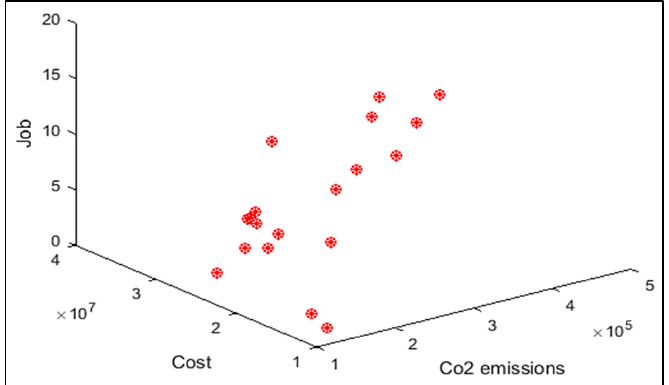
Figure 23. Pareto front of the first test problem from MOGWO.